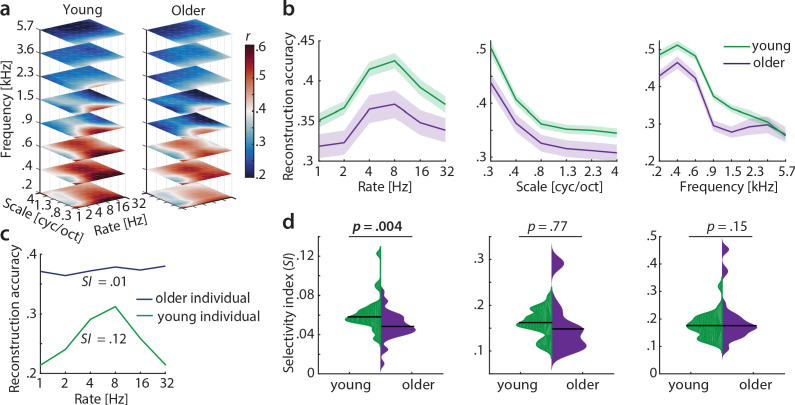
Decoding from auditory cortex.(a) Auditory cortical modulation transfer functions (MTFs) for the young and older group quantified by reconstruction accuracies (Pearson’s r between predicted an actual acoustic features). (b) Mean ± SEM of the MTFs’ marginal profiles for rate, scale and frequency for young (green) and older (violet) participants separately. (c) We quantified tuning selectivity by the selectivity index (SI; see Equation 7). For illustration purposes, we show the marginal profiles for rate in a young (green) and older individual (violet) with extreme SI values. (d) SI was compared for each acoustic dimension (rate, scale, frequency) between age groups using an exact permutation test. Black line indicates the median SI. Black line indicates the median SI. Note that when removing the extreme case in the young group (exceeding the grand average by ±2 SD) for rate SI, the mean age-group difference remains significant (p=0.026). Removing the two extreme cases in the older group for scale SI leads to a significant age-group difference (p=0.024). Note the different scaling of the plots. See Figure 5—figure supplement 1 for decoding from auditory cortex with ICA (AROMA)-cleaned data.